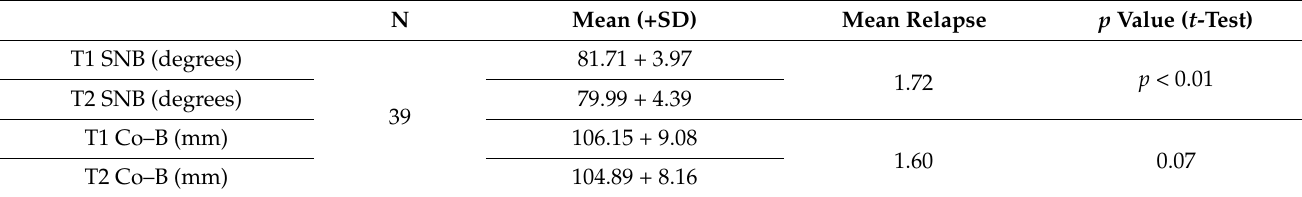
Table 1. Skeletal stability; SNB angle and Co-B